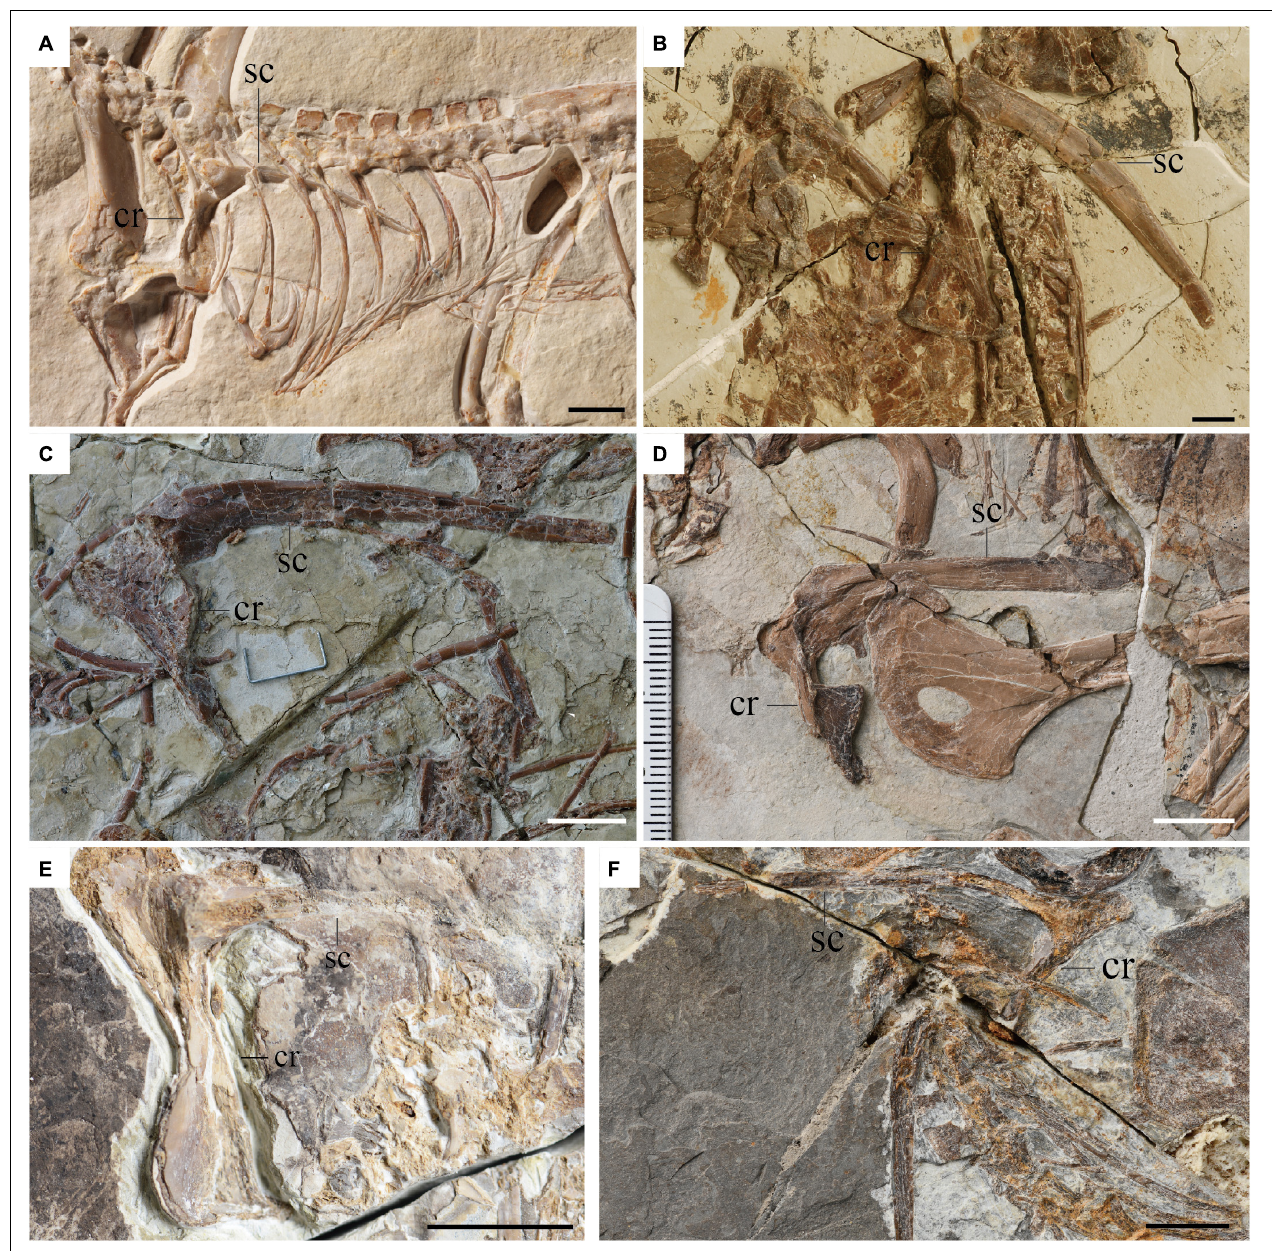
FIGURE 2 | Scapulae and coracoids of basal avialans. (A) Archaeopteryx Munich specimen; (B) Jeholornis IVPP V13886 (unpublished specimen); (C) Sapeornis IVPP V13698 (holotype); (D) Confuciusornis IVPP V14385; (E) Chongmingia STM9-9; (F) Jinguofortis IVPP V24194. Scale bar 1